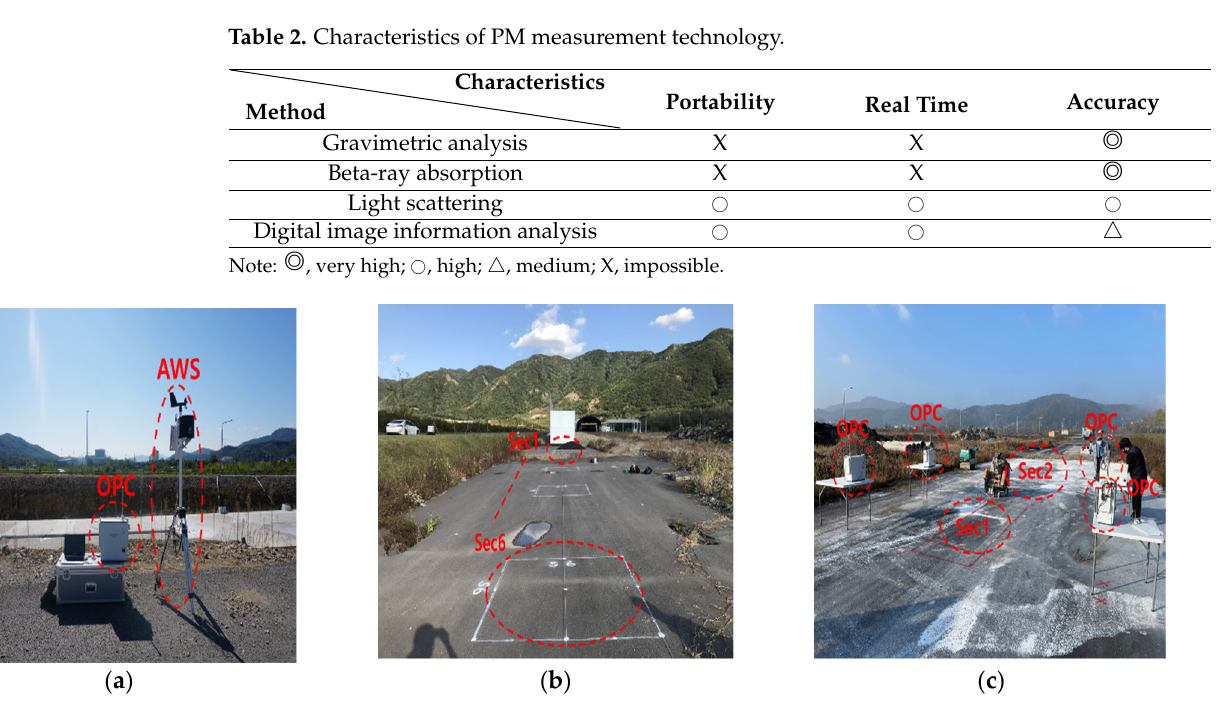
Figure 2. ( a ) Equipment for collecting background data, ( b ) first field testbed (sections 1–6), and ( c ) second field testbed (sections 1, 2). Table 3. Measurement conditions for excavation and restoration work.